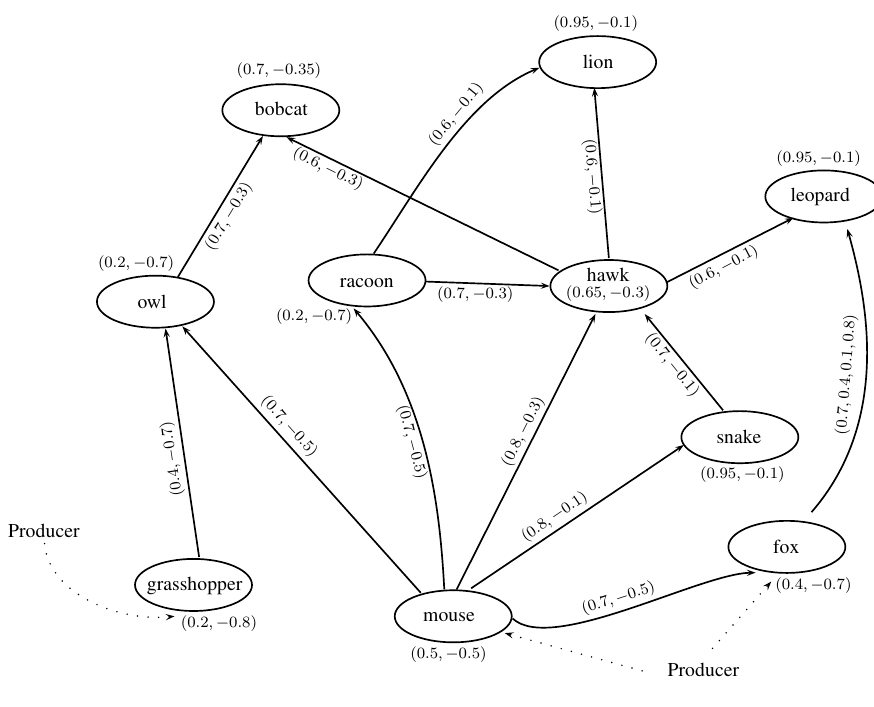
Figure 2.6: Bipolar fuzzy food web Figure 6. Bipolar fuzzy food web.